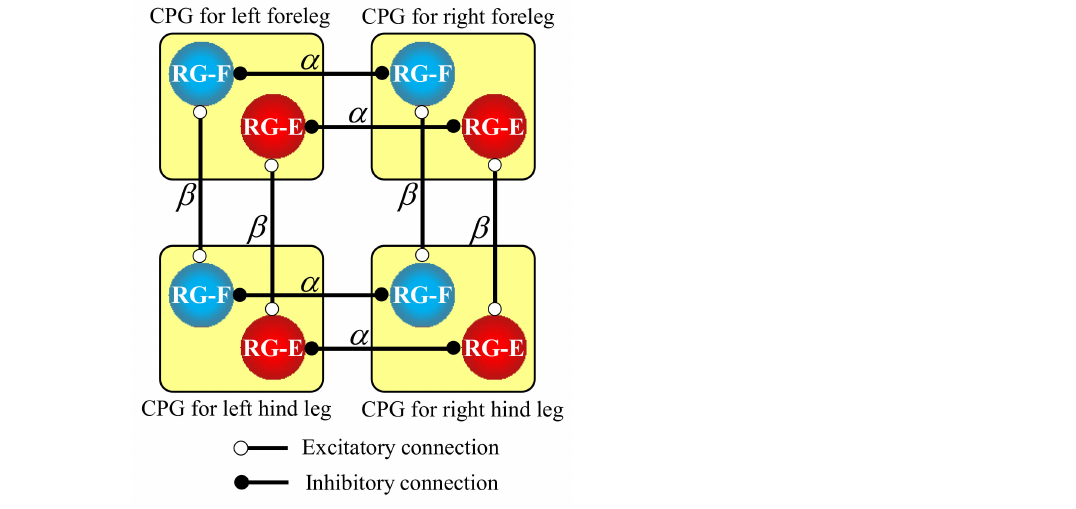
Figure 6. Hard-wired CPG network between the four legs to produce a pace gait for our quadruped